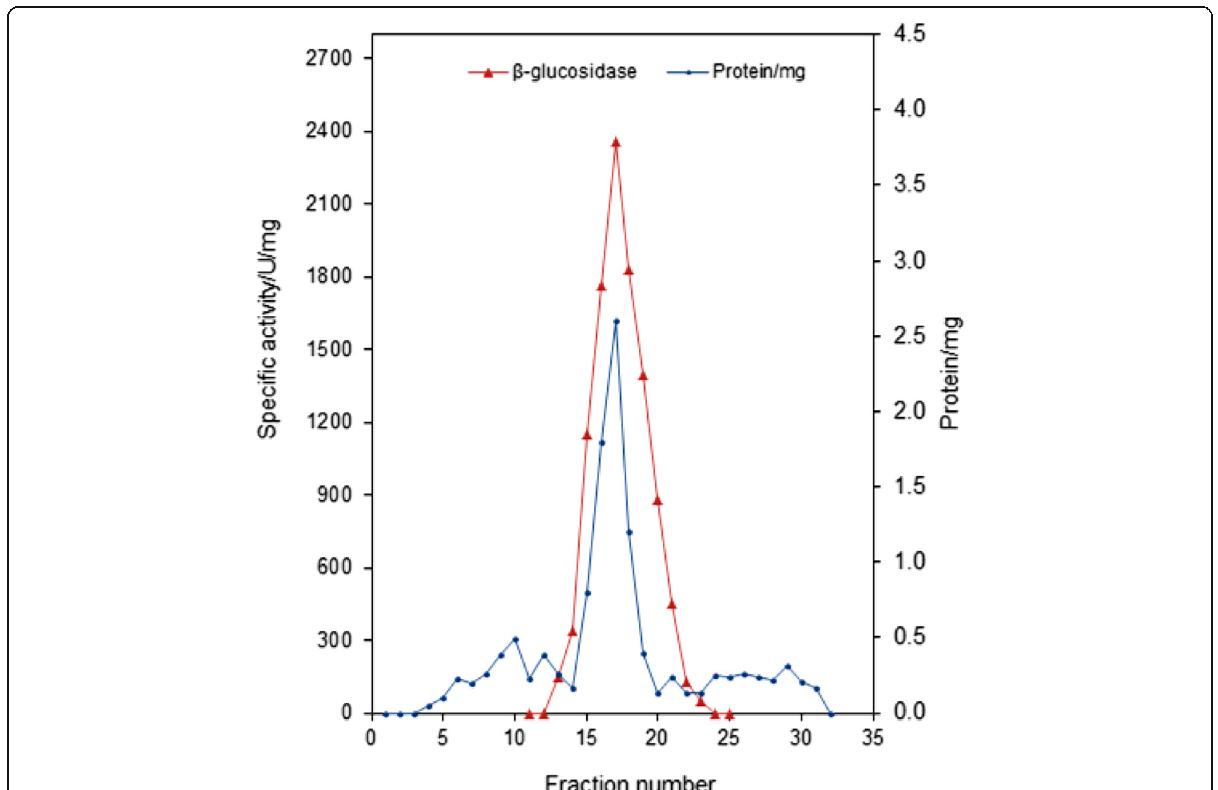
Fig. 2 Elution diagram of β -glucosidase of Aspergillus sp. DHE7 from Sephadex G-100